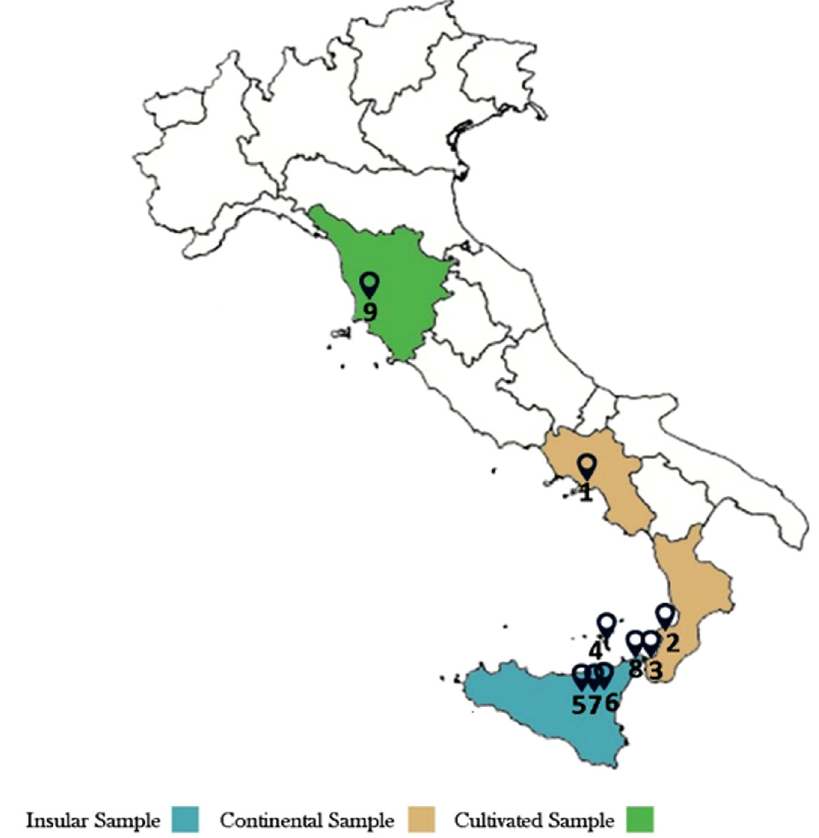
Figure 1. Map of samples (1–9) distributions.